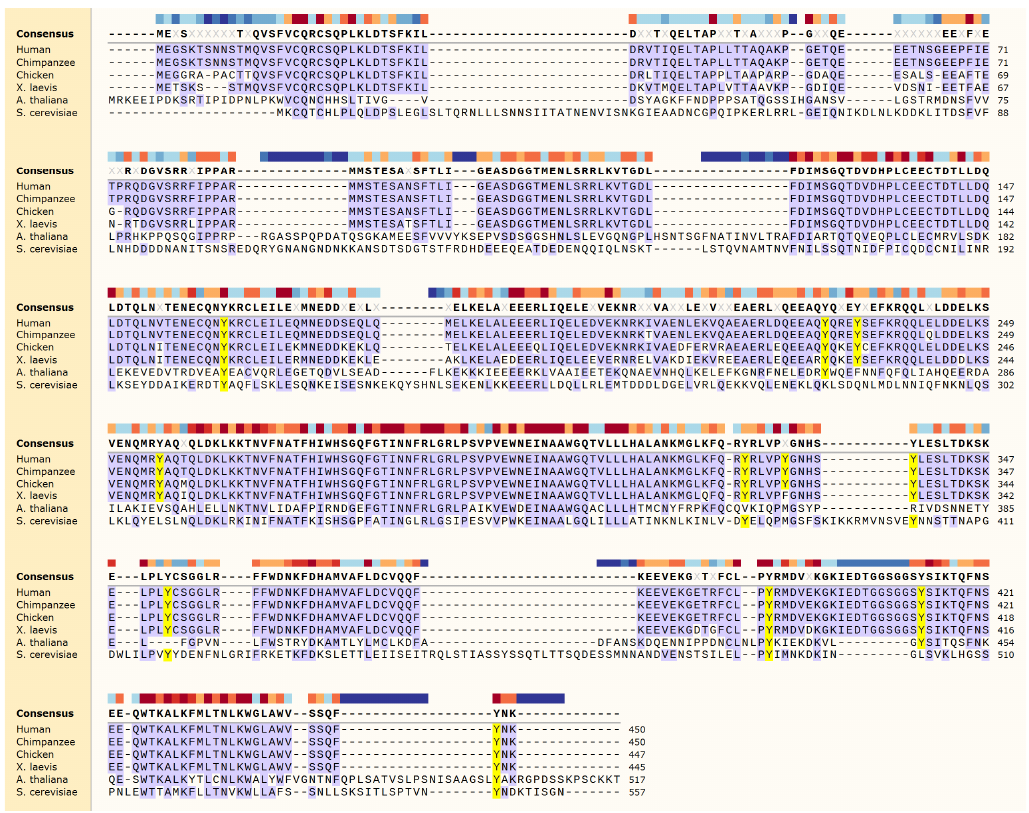
Figure 2. Beclin 1 protein sequence alignment. Tyrosine residues are highlighted in yellow. Color-coded bar at the top indicated conservation degree. Alignment was generated using Multiple Sequence Comparison by Log-Expectation (MUSCLE) algorithm in SnapGene (GSL Biotech).